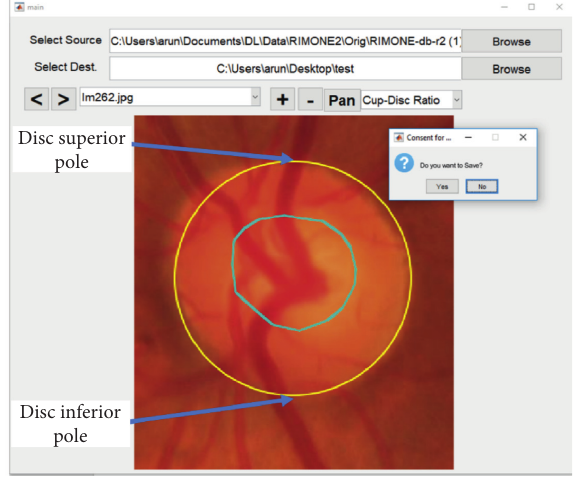
Figure 1: The interface of “CDR annotator,” the proprietary cup/ disc ratio grading software. The optic cup is circled in